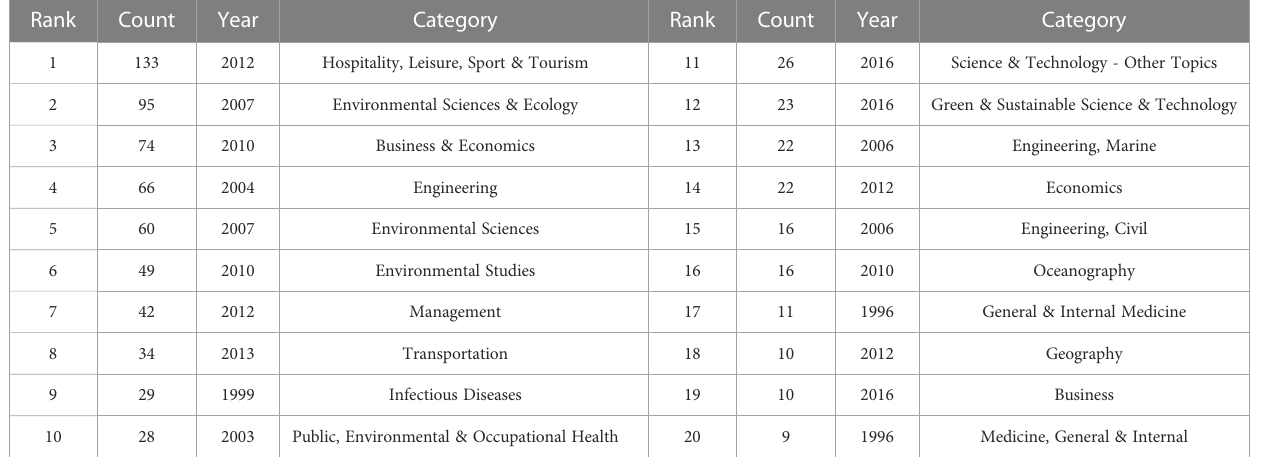
TABLE 3 Top 20 disciplines in cruise research.